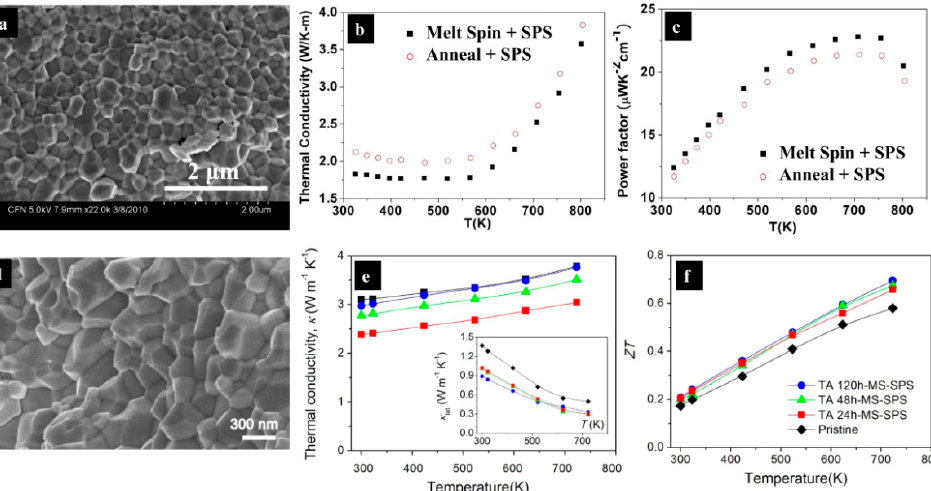
Figure 6. ( a ) SEM image of fracture surface of Ce 0.9 Fe 3 CoSb 12 material; temperature dependence of ( b ) power factor and ( c ) thermal conductivity for the Ce 0.9 Fe 3 CoSb 12 material [49]; ( d ) SEM image of Yb 0.9 Fe 3 CoSb 12 sample; temperature dependence of ( e ) thermal conductivity and ( f ) ZT values for Yb 0.9 Fe 3 CoSb 12 material prepared under different preparation conditions. The inset shows the temperature dependence of lattice thermal conductivity [50].